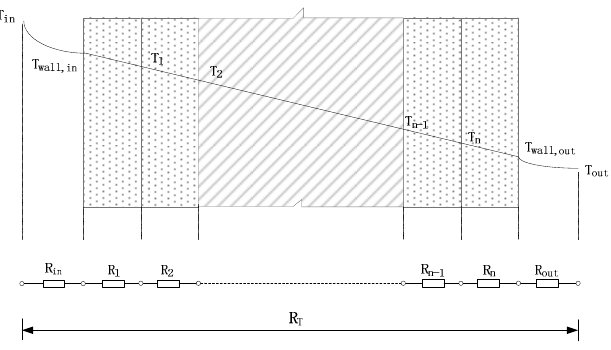
Figure 2. The thermal resistance of heat transfer through the kiln to the atmosphere. Table 2. Thermal resistance equations [28,29]. Equation Explaination where a is convection coe ffi R in = 1 a (1)